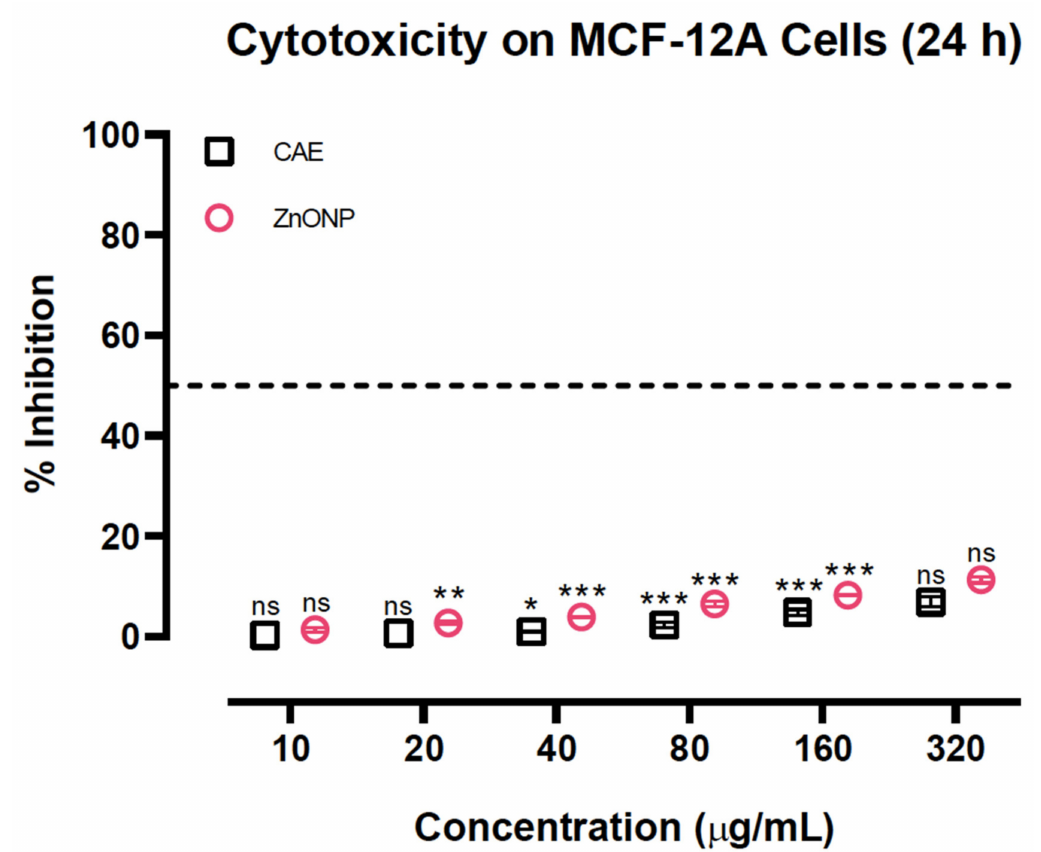
Figure 11. Cytotoxicity of CAE and ZnONPs on normal human breast MCF-12A cells. Results are reported as mean ± SEM for n = 3, and a p-value of < 0.05 was considered to be significant; *p = < 0.033, **p = < 0.002, ***p = < 0.001, ns = not significant.